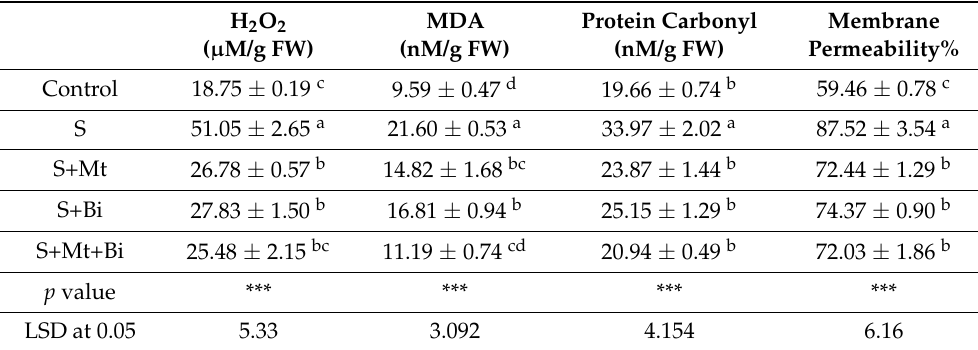
Table 3. The effect of melatonin (Mt) and/or biochar (Bi) supply on oxidative biomarkers of borage plants grown in a saline medium (S, 5000 ppm